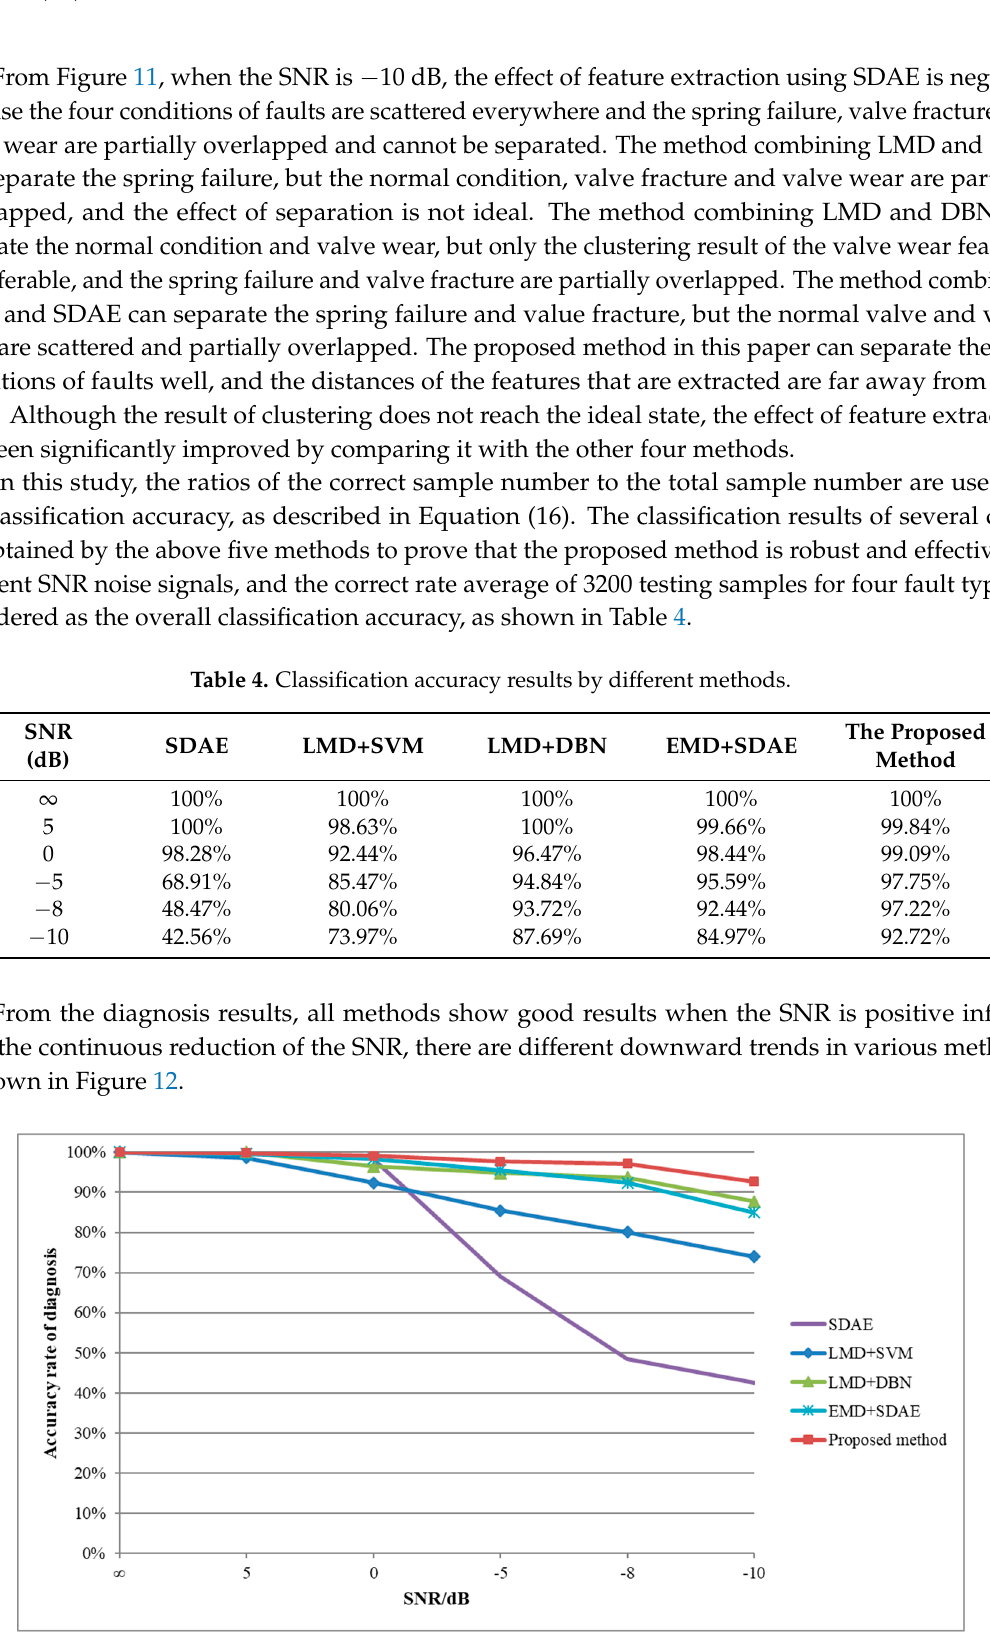
Figure 12. Compressor diagnosis results of the employed methods with different SNRs.